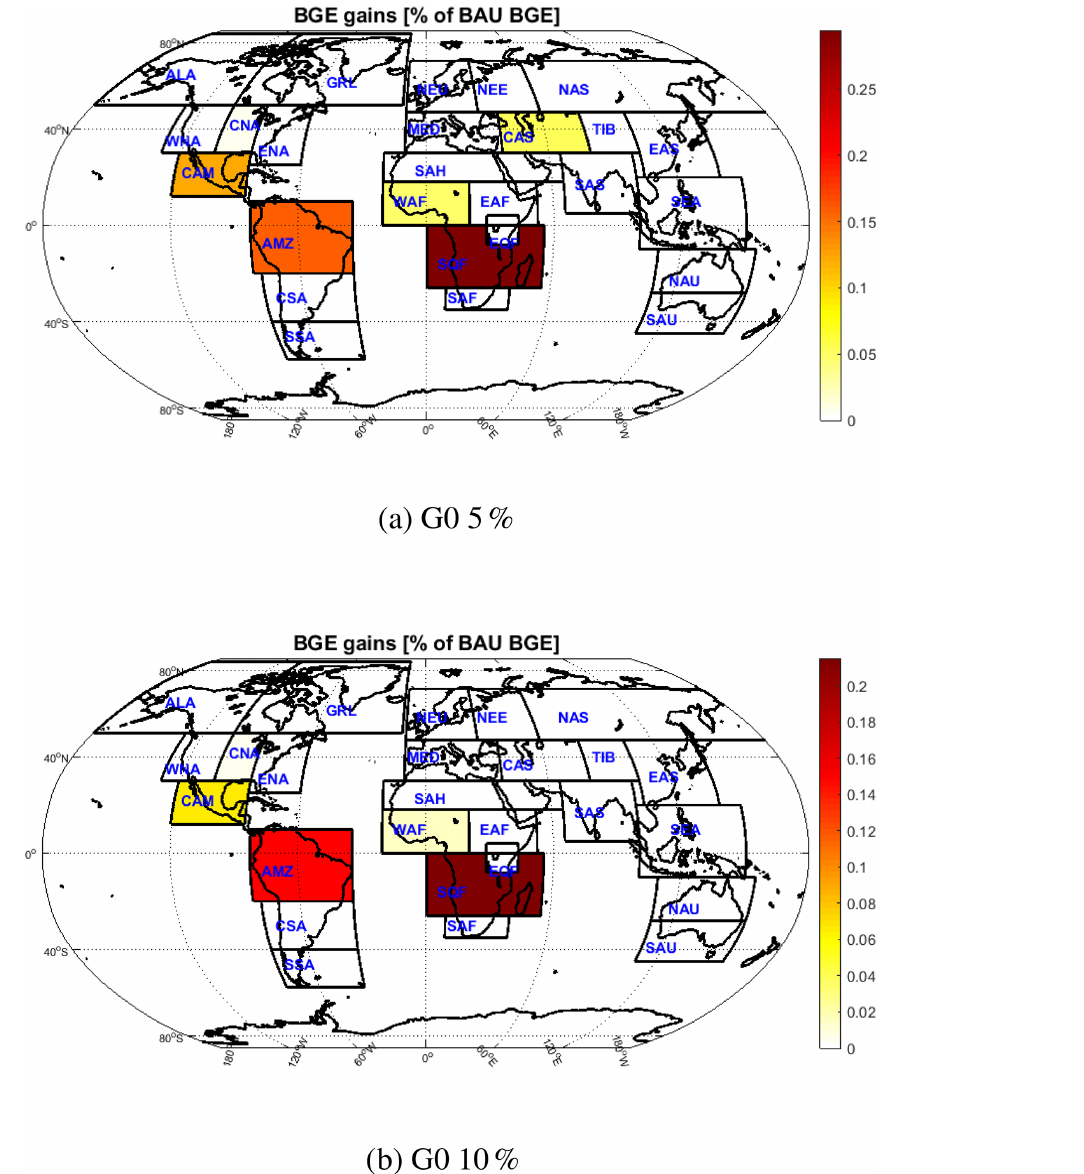
Figure 6. Economic gains from omission on regional guardrails. Darker colors indicate more economic gain per region when the precipitation leaves the respective regional corridor. 5% and 10% denote the fraction of the standard deviation of natural variability as the extra admissible